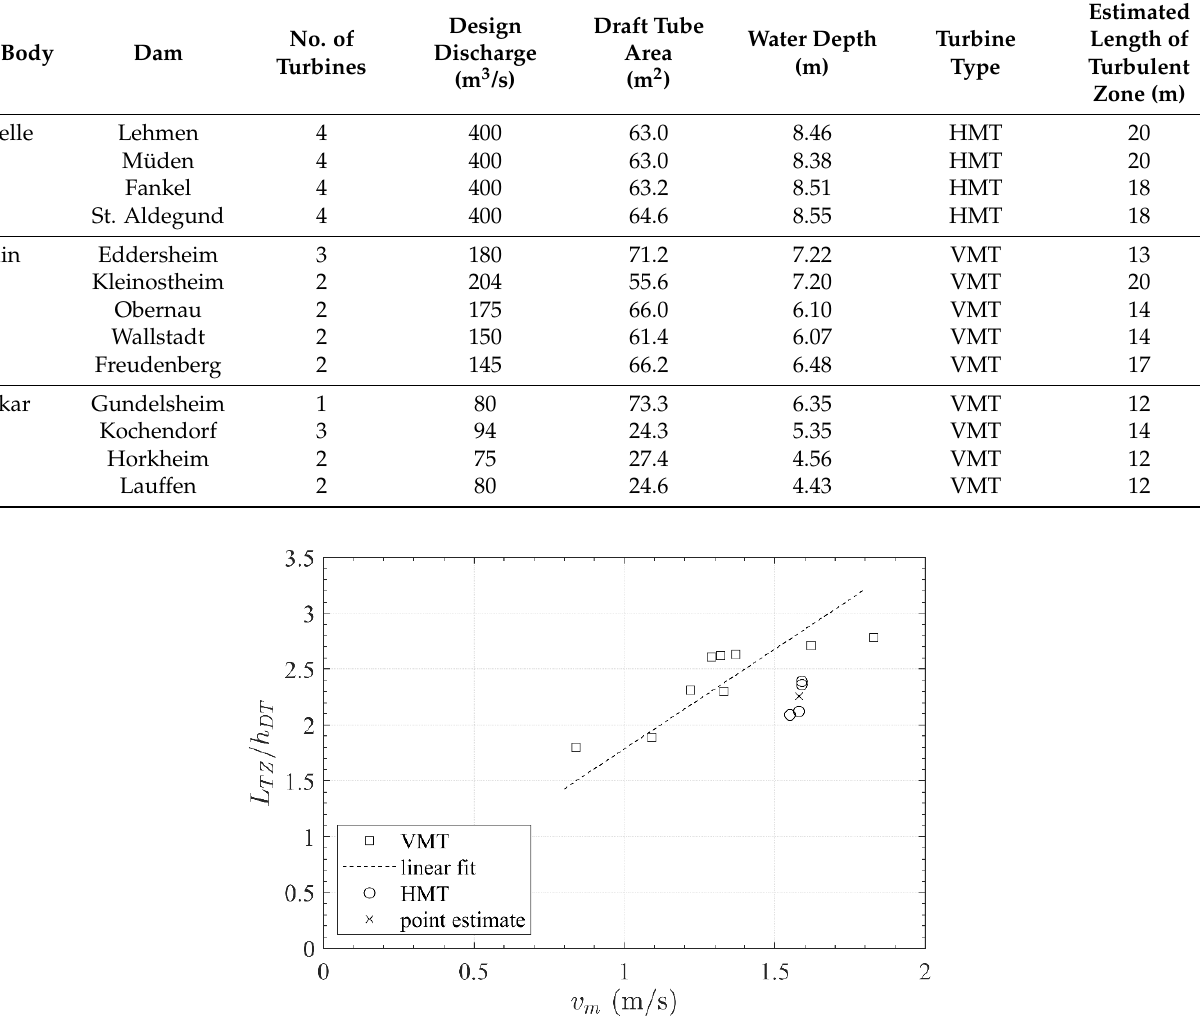
Deviation of the points from linear may be explained by (1) the subjective nature of the observations, (2) missing parameters such as draft tube or channel geometry and other site- specific attributes, and (3) limited number of observations and short range of conditions for HMT. Table 1. Parameters of the inspected dams where the length of turbulent zones were assessed by visual observation; VMT or HMT = vertically or horizontally mounted turbines.